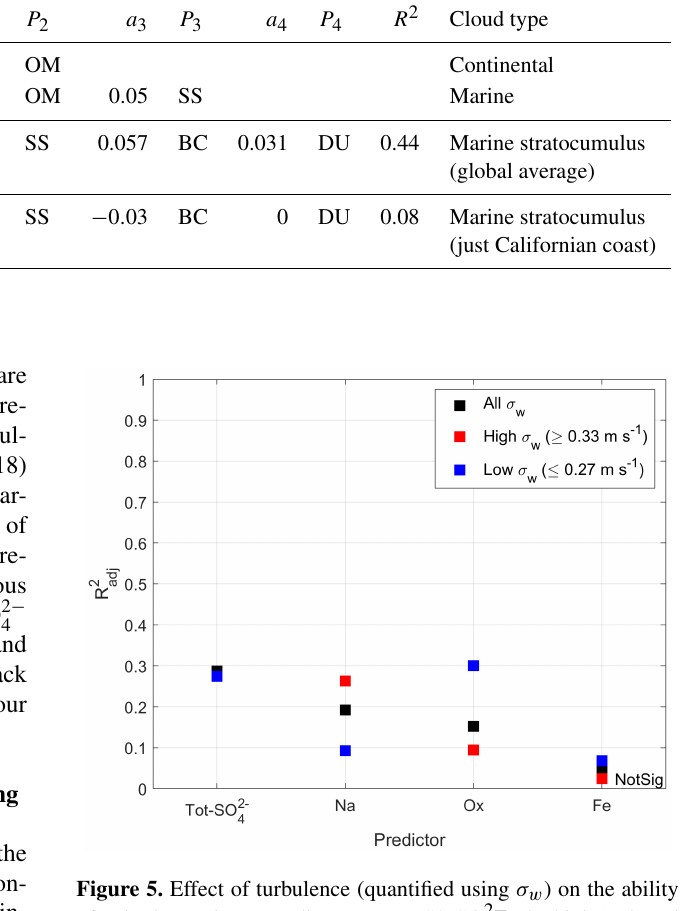
; the high (red) and 4